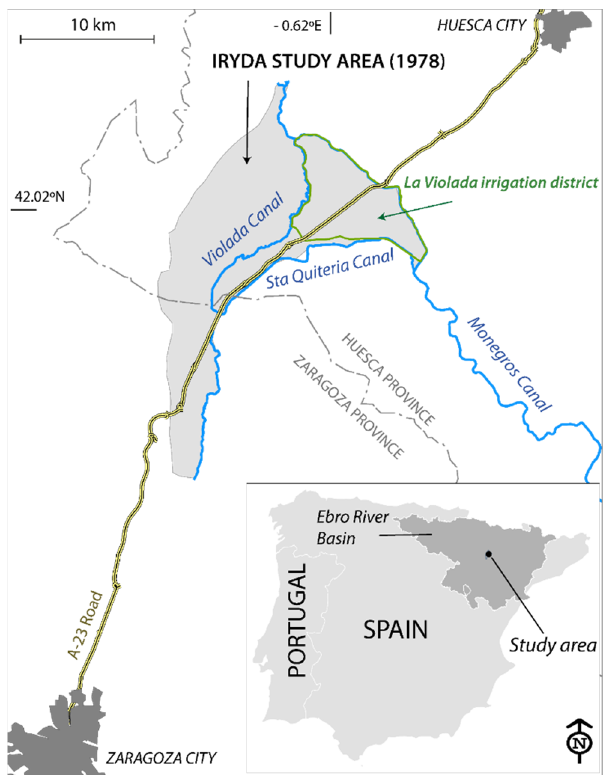
Figure 1. Location of the area studied by IRYDA [1] that includes the Violada irrigation district, outlined in green.